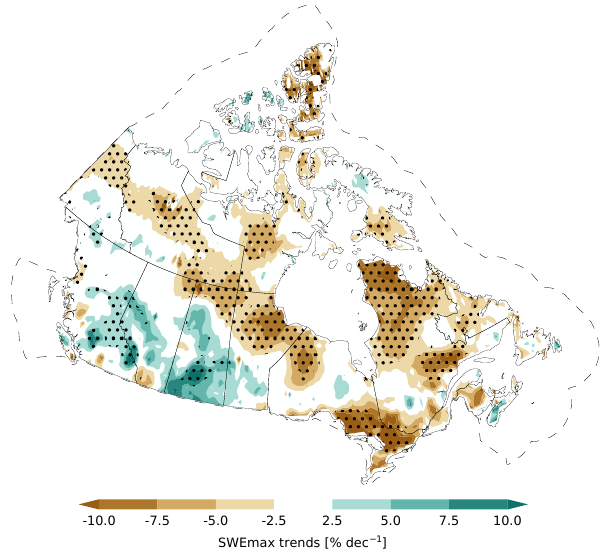
Figure 4. SWEmax trends for 1981–2015. Stippling indicates pointwise significance at the 90th percentile.